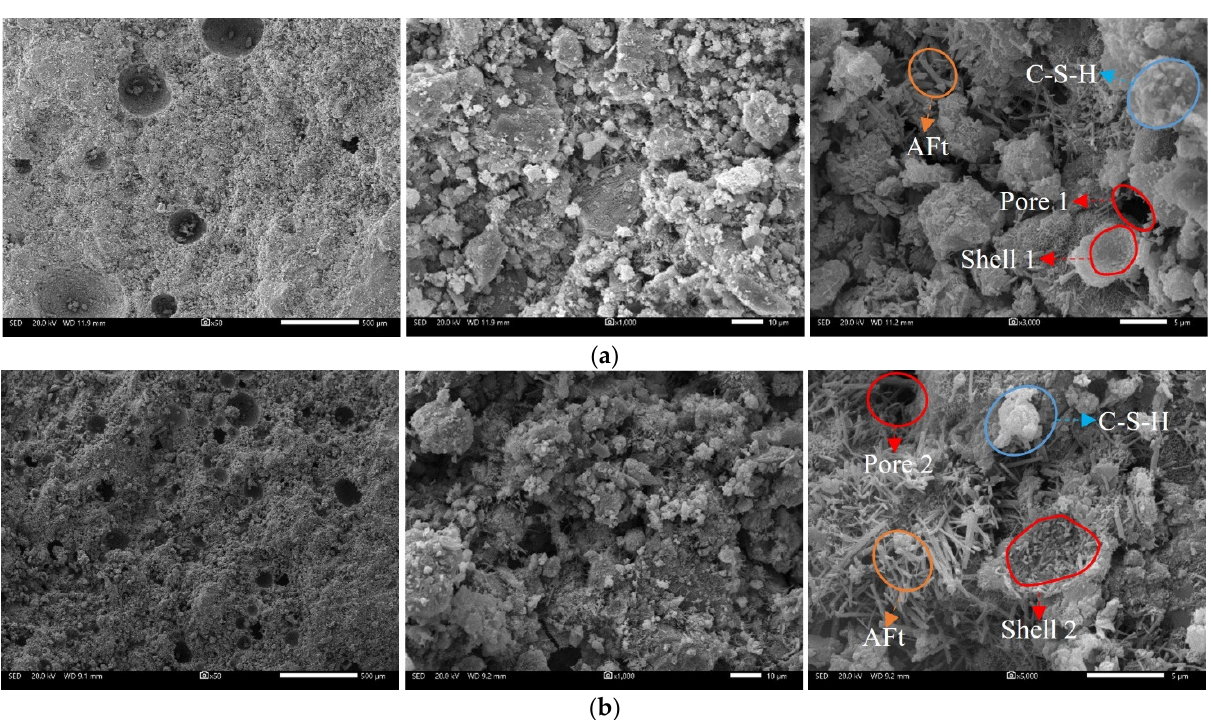
Figure 13. SEM images of an FCPB sample (SC = 77 wt.%, CTR = 1:5, and T = 28 d): ( a ) FC = 10% and ( b ) FC = 30%.